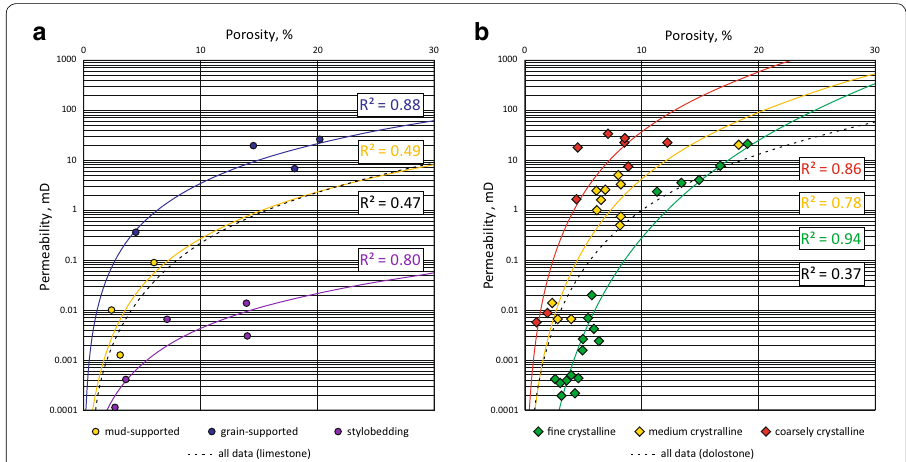
Fig. 11 Empirical poro–perm relationship for distinct petrographic classes excluding samples showing secondary porosity (fractures, vugs). Limestones and dolomitic limestones ( a ) show significant difference in the poro–perm relationship compared to dolostones ( b ). Dolostones tend to higher permeability with increasing porosity than limestone and dolomitic limestone classes. The lines represent power laws for each individual